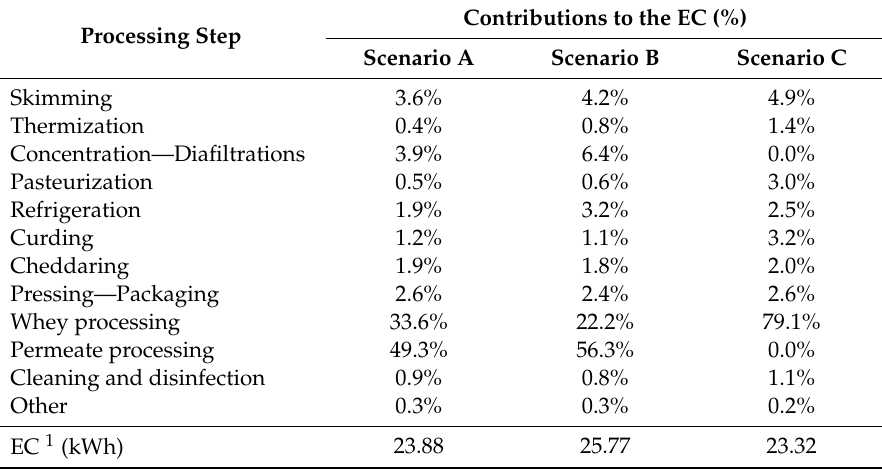
Table 9. Contribution of operating steps to the electricity consumption (EC) of the processing stage for scenarios A, B, and